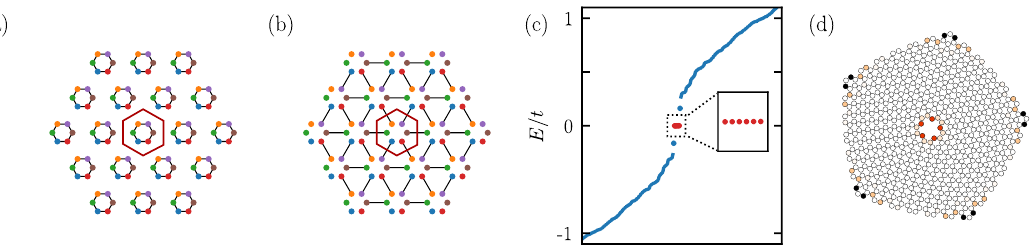
Figure 12: Model of a 2D second-order topological superconductor in class D pro- tected by sixfold rotation symmetry: (a), (b) depiction of the model in the two fully dimerized limits, where (a) describes the trivial phase H and (b) the second-order triv topological phase H . The unit cell (red hexagon) consists of six Majorana fermions topo depicted by different colors. For a lattice with π/ 3 disclination and model parame- = 1.5 and t = 0.5, we show in (c) the spectrum close to E = 0 and in (d) ters t 1 2 the real-space weights of the six zero modes. In our model, there is another pair of in-gap modes localized at the disclination. These modes are not anomalous and can be pushed into the bulk spectrum by a local deformation at the